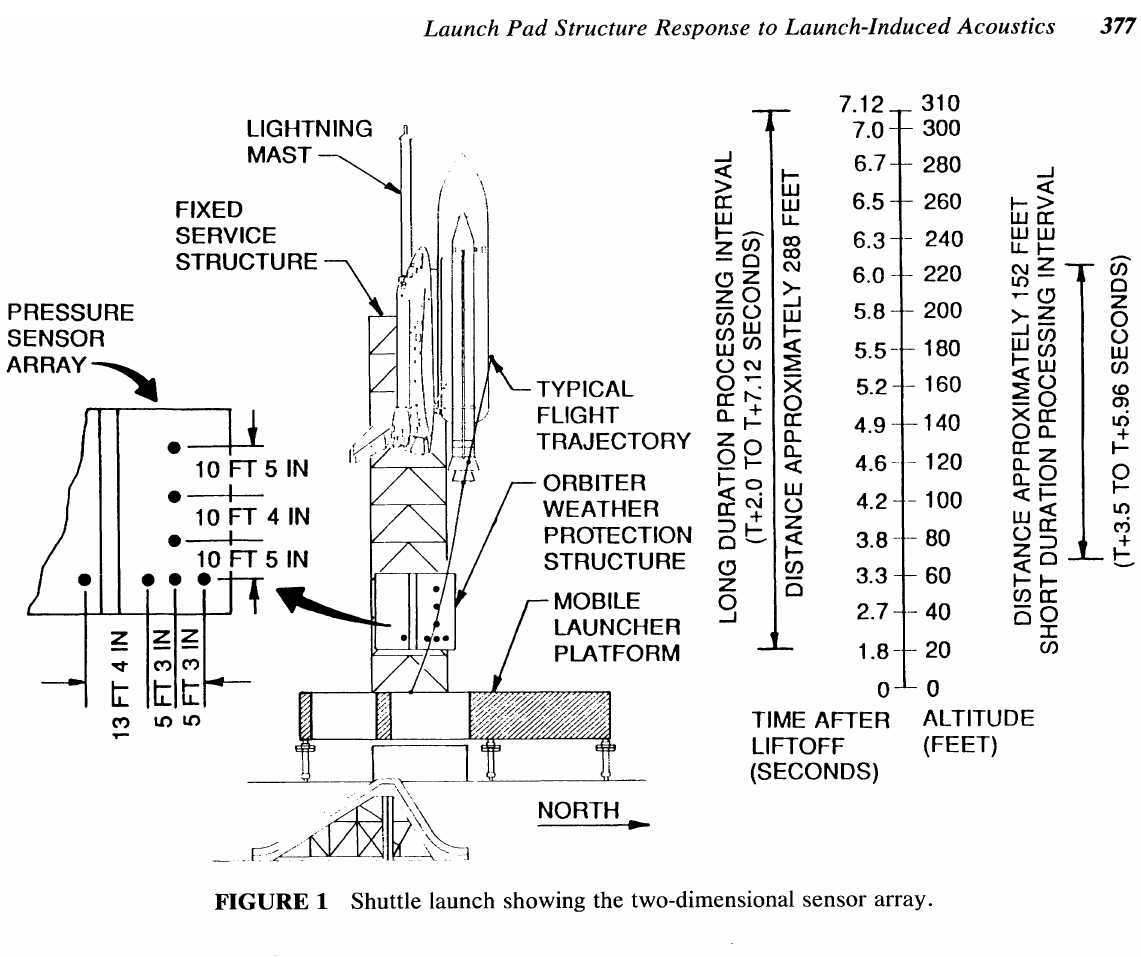
FIGURE 1 Shuttle launch showing the two-dimensional sensor array.